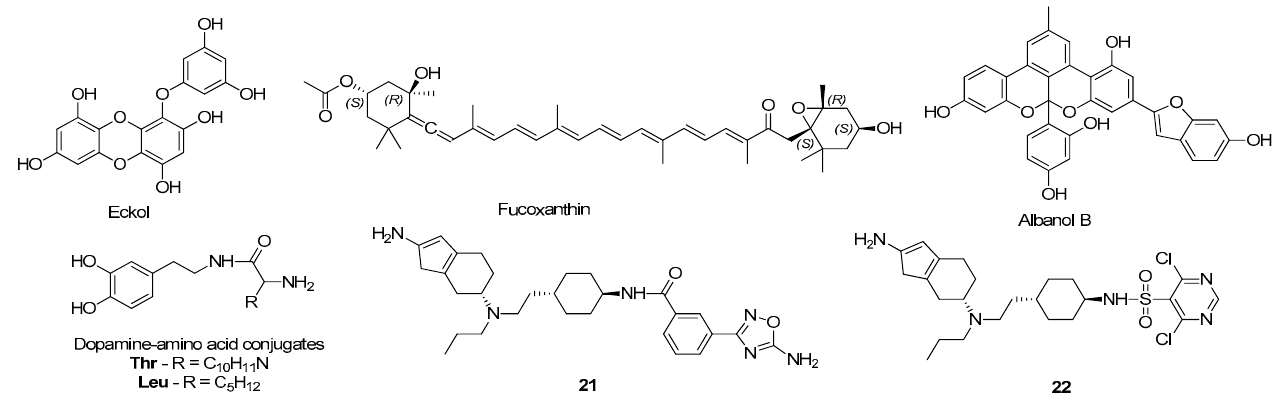
Figure 19. Structures of the studied DA.